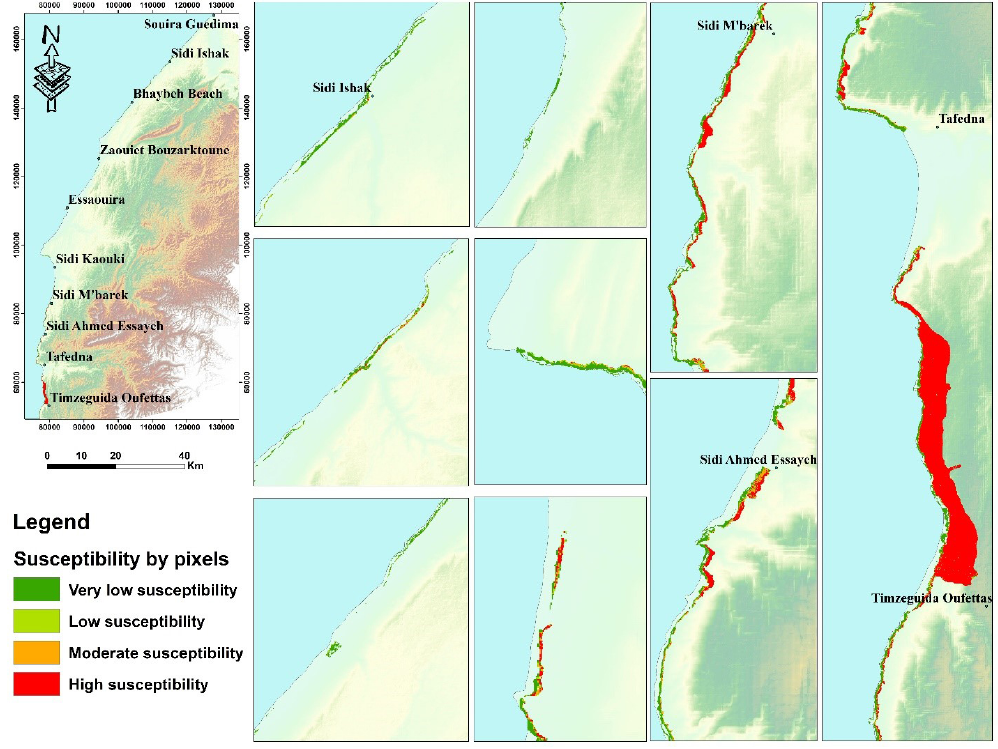
Figure 9. Landslide susceptibility map using the pixel